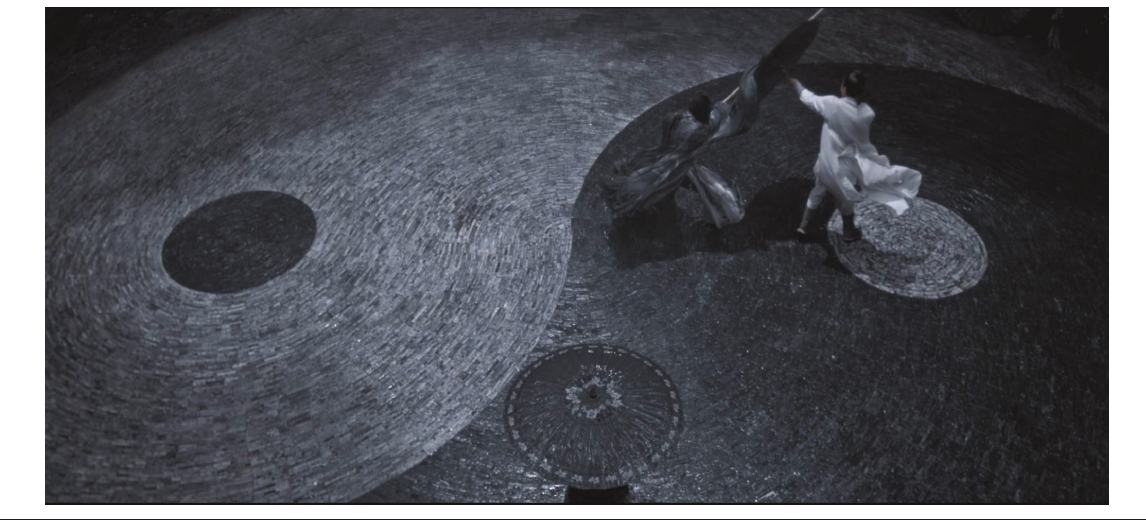
Figure 6. Film still of the clandestine cave, from Shadow (Source: Blu-ray distributed by Universal Pictures)